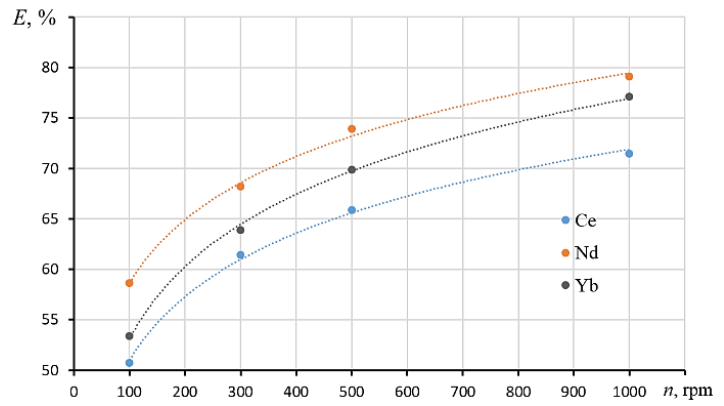
( b ) ( c ) Figure 4. Dependence of lanthanide recovery on temperature and stirring time: ( a ) for Ce; ( b ) for Nd; ( c ) for Yb. An increase in temperature led to a regular increase in the degree of extraction. The dependencies were approximated by logarithmic dependence with a validity of 98%, the empirical approximation equations are shown in Table 5. Table 5. Degree of extraction versus time and temperature. Т, ° С